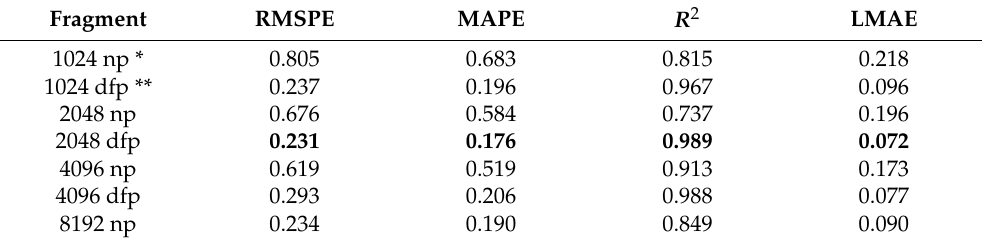
Table 2. Values of different quantitative measures of recovery performance in the range of 0.2–1.2 Hz. Fragment